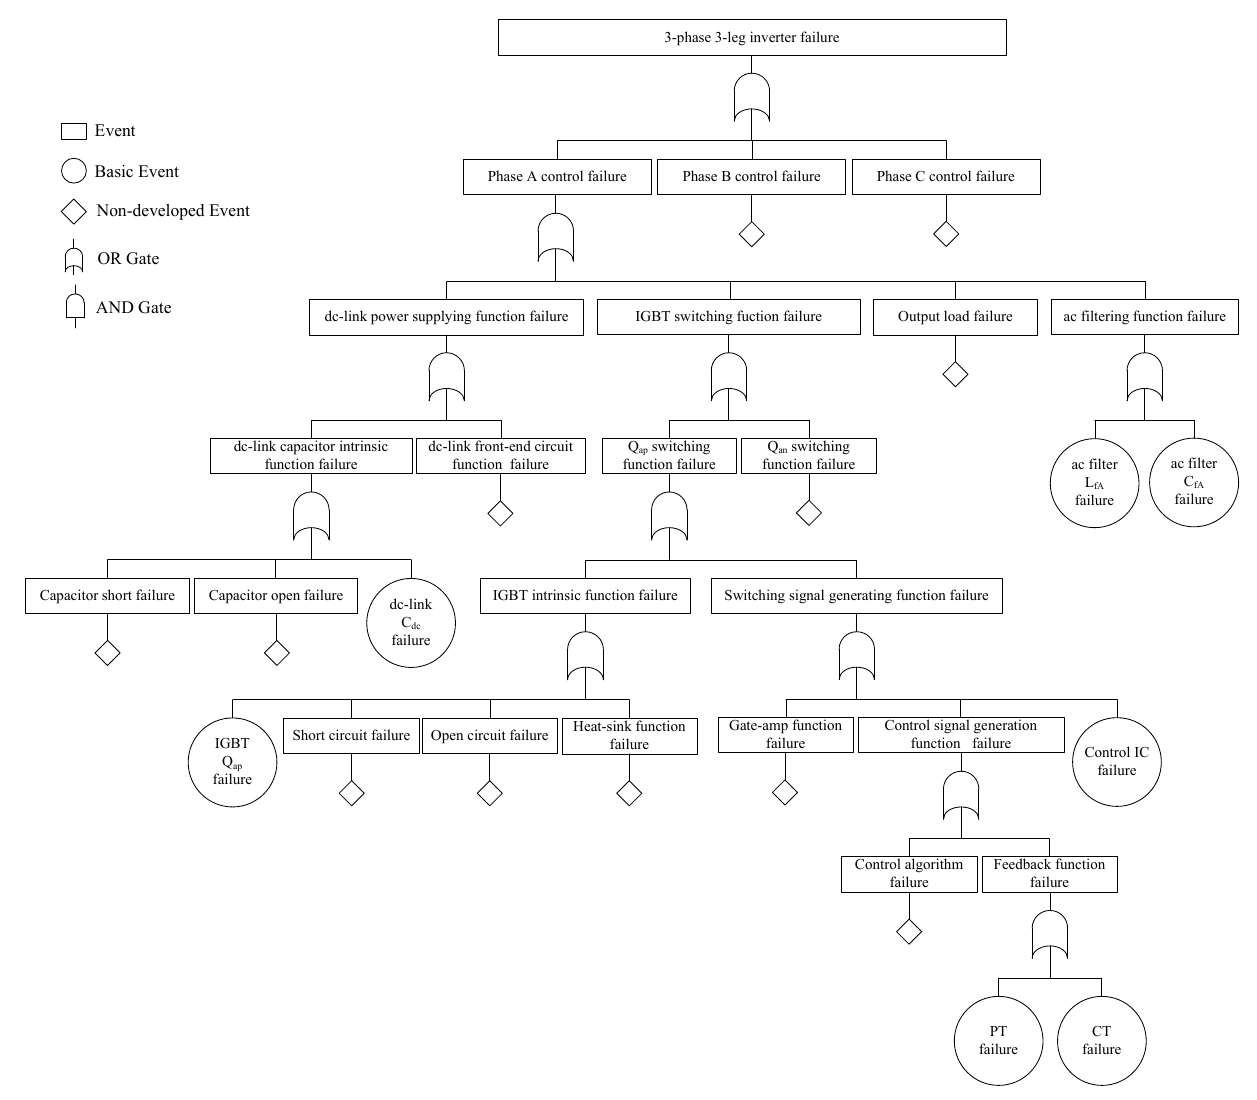
Figure 9. Fault-tree of three-phase 3-leg inverter.